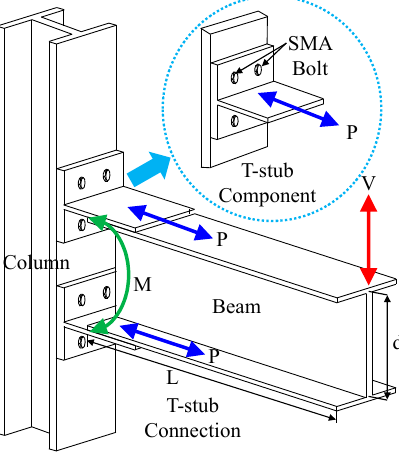
Figure 2. Schematic of the T-stub component and connection.